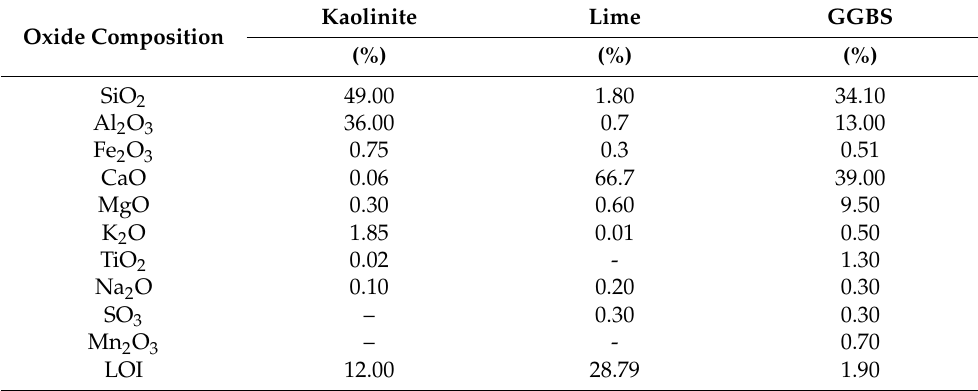
Table 1. Chemical composition of materials.